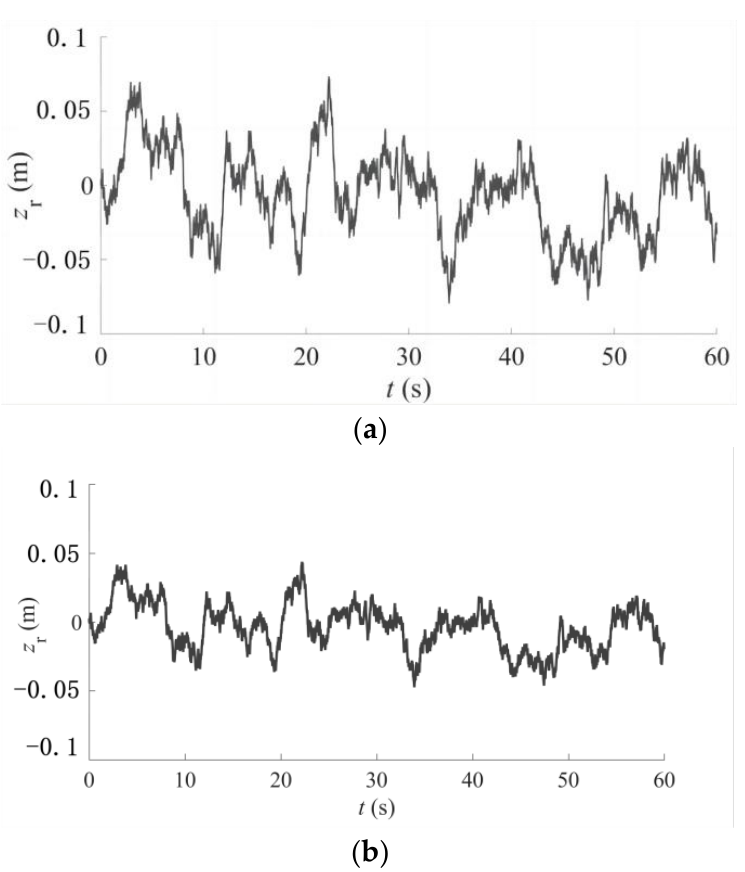
Figure 6. The simulation curve of road pavement. ( a ) Road pavement under the national standard C-grade road surface. ( b ) Road pavement under the national standard B-grade road